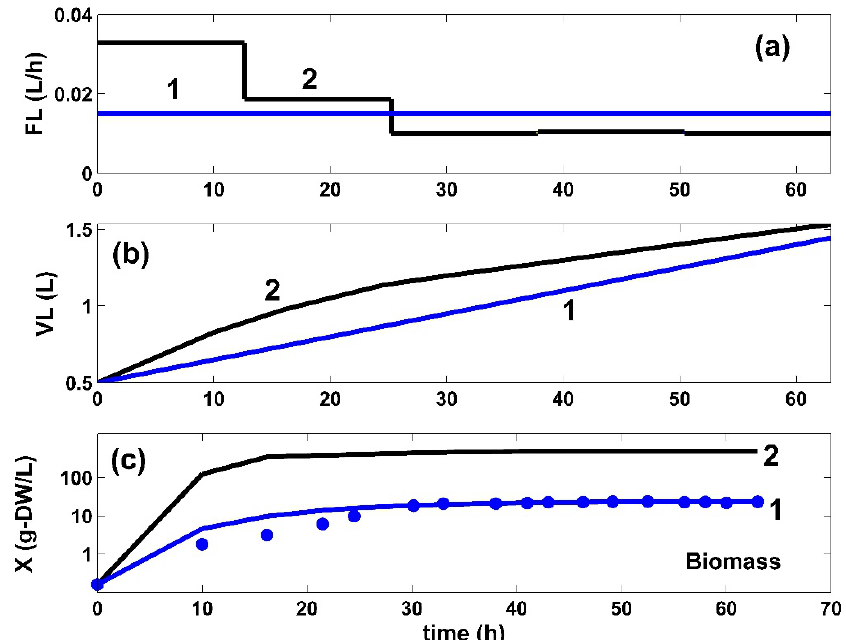
Figure 8. ( a ). The time stepwise optimal policy of the feed flow-rate (FL), ( j = 1, . . . , 5 time-arcs) in the bioreactor (—) for the FBR operated in two alternatives: (i) (2, black) optimal operation derived in this paper (variable fed [GLC] and variable feed flow rate), and (ii) (1, blue) trajectories under nominal, nonoptimal operation of (Table 1), with a constant fed [GLC] and a constant feed flow rate. Both cases use the same modified E. coli T5 strain. (b) The liquid volume (VL) dynamics in two alternatives: (i) using the optimal policy of the variable feed flow rate (FL) in the bioreactor (2, black) derived in this paper, or (ii) using (1, blue) the nonoptimally operated FBR under the nominal conditions of Table 1, with a constant fed [GLC] and a constant feed flow rate. ( c ). The model-based predictions of the biomass (X) concentration in the same FBR with using the modified E. coli T5 strain, but operated in two alternatives: (i) (2, black) optimal operation derived in this paper (i.e., variable fed [GLC] and variable feed flow rate), or (ii) (1, blue) simulations and the experimental data ( • , blue) of Chen [71] under nominal, nonoptimal operation of Table 1, with a constant fed [GLC] and a constant feed flow rate. Table 1. The nominal initial operating conditions of the FBR used by Chen [74] to collect the kinetic data of the TRP synthesis using a suspended culture of genetically modified E. coli cells (T5 strain). More experimental details were given by Chen [74].